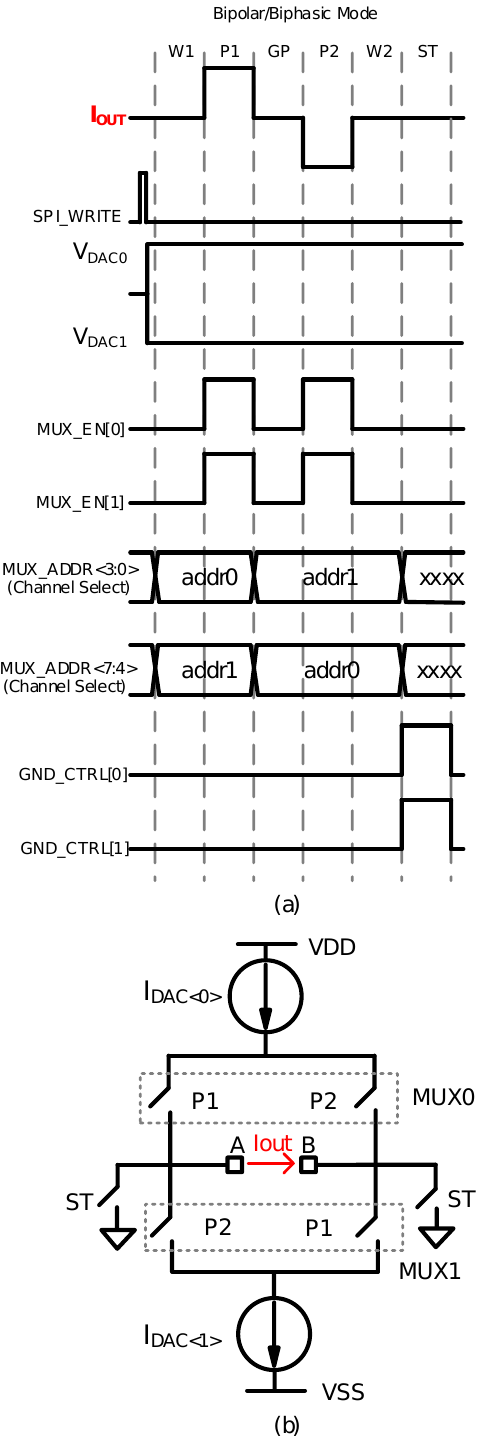
Figure 3. ( a ) Example timing for biphasic, bipolar stimulation and ( b ) the resulting stimulation